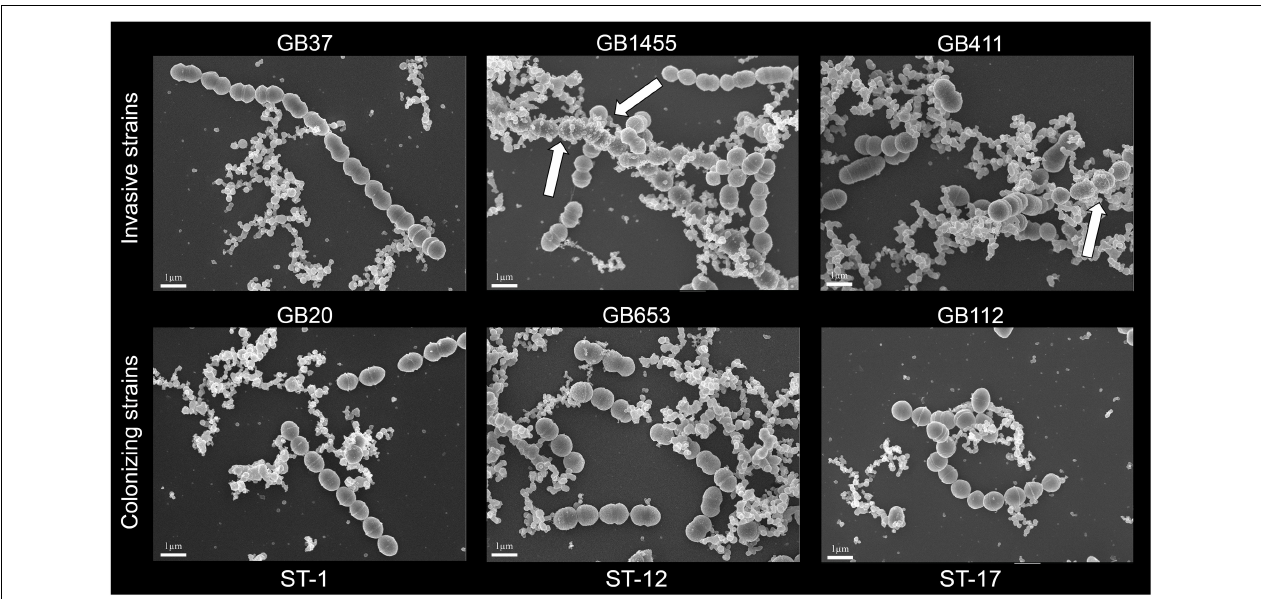
FIGURE 1 | Scanning electron microscopy (SEM) of membrane vesicles (MVs) from overnight cultures of six group B streptococcal strains, which were visualized by SEM at 10,000 × magnification following growth to stationary phase. White arrows show MVs that are closely associated with bacterial cells. A minimum of 2 replicates per strain were examined and the SEM scale bars represent 1 µ m length.